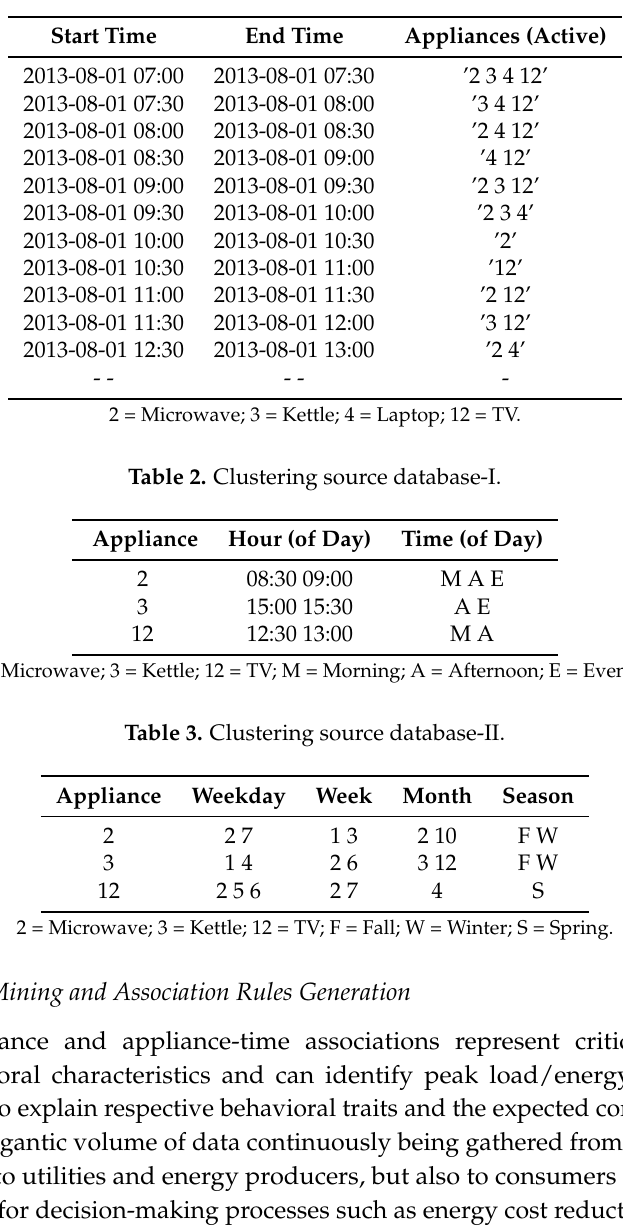
Table 1. Frequent pattern source database.